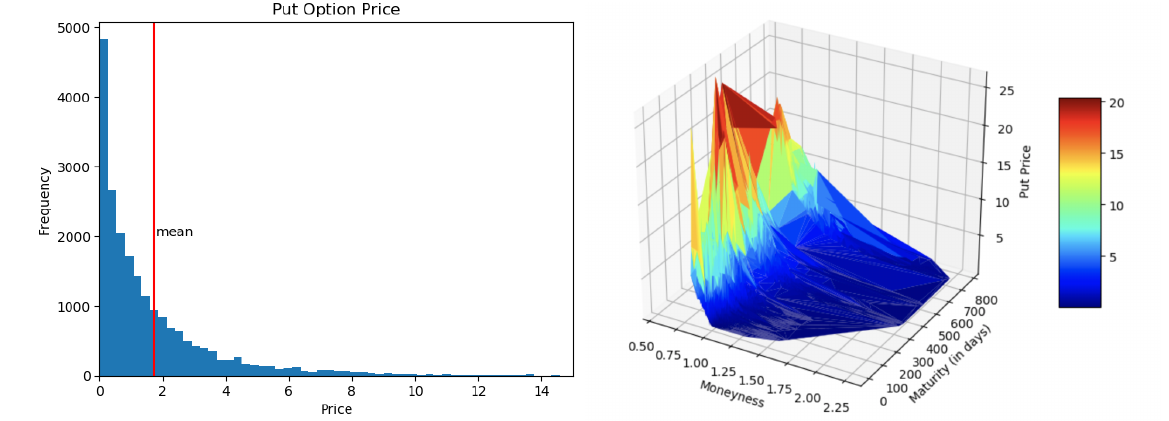
Figure 5. Put prices: output variable.